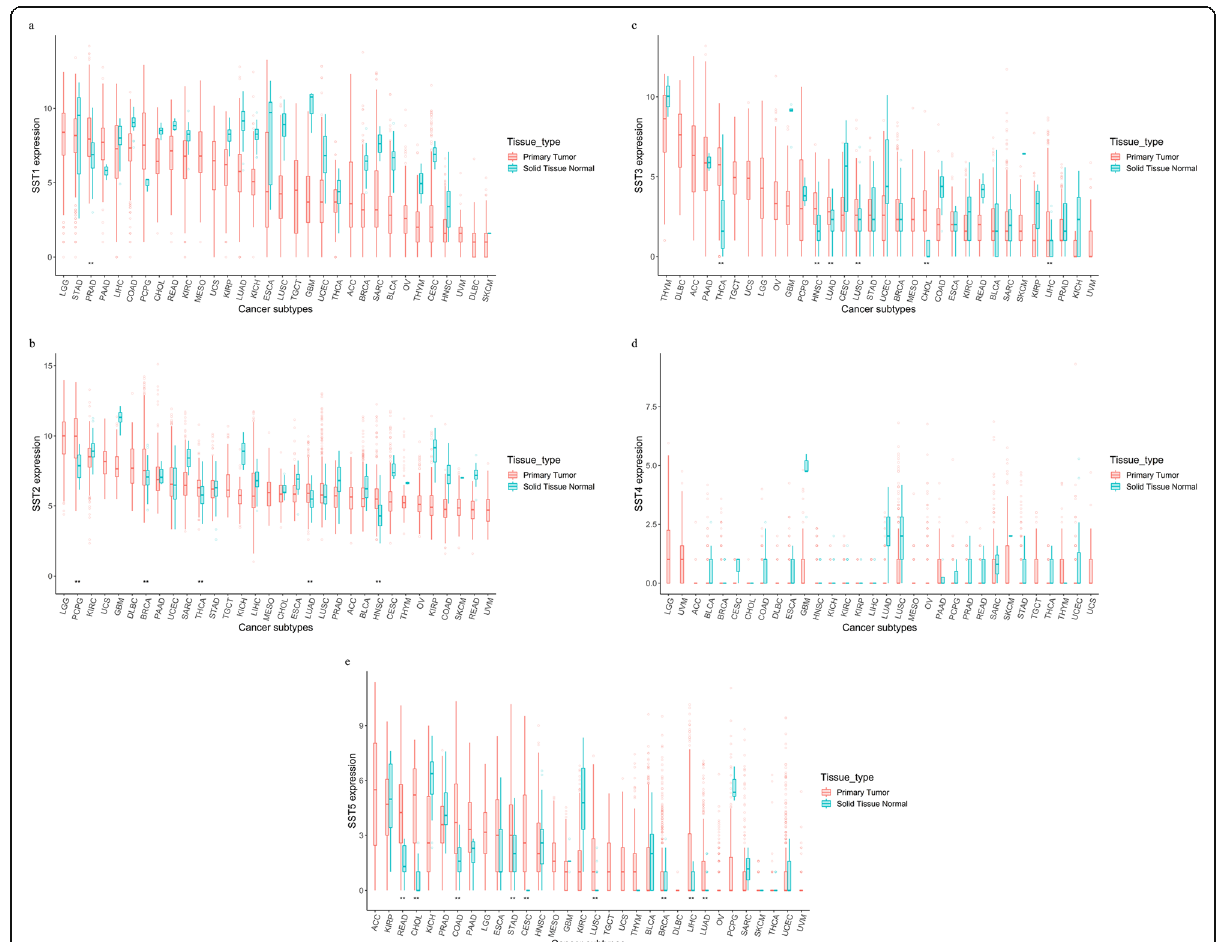
Fig. 1 SST expression level of primary tumor tissue and normal solid tissue in the pan-cancer. Two asterisks (**) mean statistical significance, p value lesser than 0.05. a SST1 expression. b SST2 expression level in primary tumor tissue was revealed higher than that in normal solid tissue in five cancer subtypes: PCPG, BRCA, THCA, LUAD, HNSC. Median value of SST2 expression was the highest in LGG and lowest in UVM. c SST3 expression. d SST4 expression. e SST5